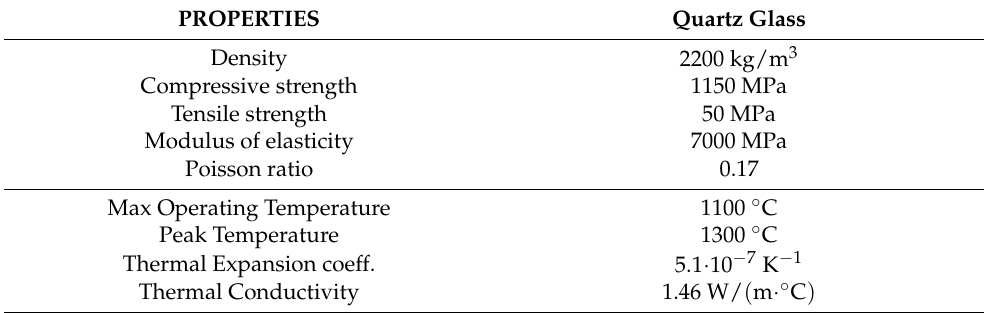
Table A2. Mechanical and thermal properties of Quartz Glass provided by Squall International bv (NL), see http://squallquartz.com/ (Accessed Date: 9 November 2021).